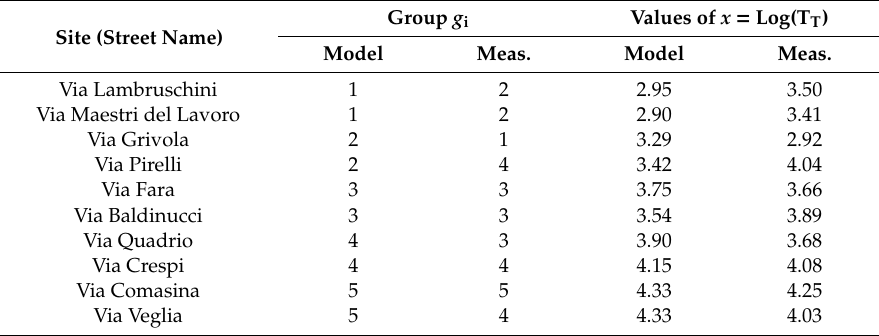
Table 5. Group assignment according to model calculations and flow measurements in correspondence to 10 noise monitoring stations.